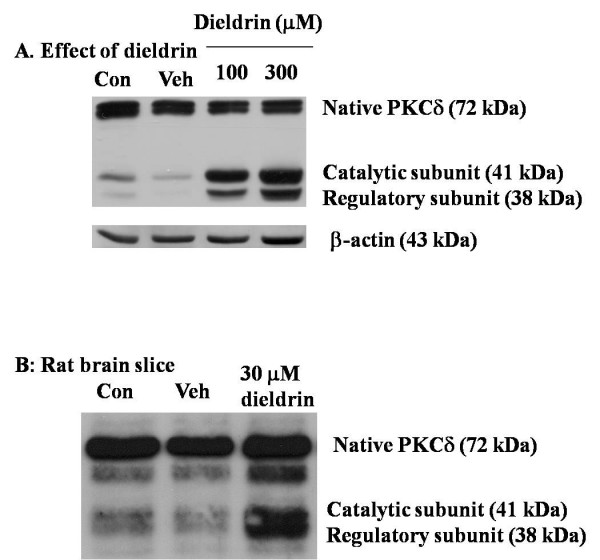
Proteolytic cleavage of PKCδ following dieldrin treatment in N27 cells. In A, N27 cells (~1 × 107 cells) were exposed to 100 μM or 300 μM dieldrin for 3 hr at 37°C, and cytosolic proteins were collected as described in "Materials and Methods." Approximately 5 μg of cytosolic proteins were resolved on 10% SDS-polyacrylamide gel, revealing native PKCδ (72 kDa), the catalytic subunit (41 kDa) and the regulatory subunit (38 kDa) of proteolytically cleaved PKCδ. In B, rat brain slices were exposed to 30 μM dieldrin for 3 hr. PKCδ was detected by Western blot and equal protein loading was confirmed by reprobing with β-actin (43 kDa). Veh represents 0.2% DMSO.